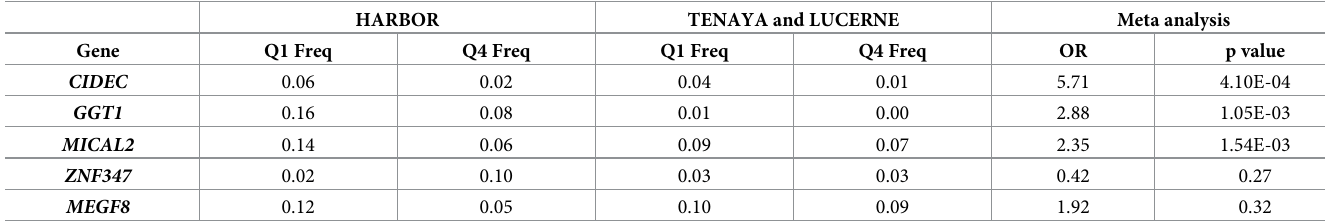
Table 3. Results from rare variant burden test comparing quartile Q1 and quartile Q4 in a combined analysis (meta) of AMD patients from the HARBOR (discov- ery), TENAYA and LUCERNE (replication) trials. OR = odds